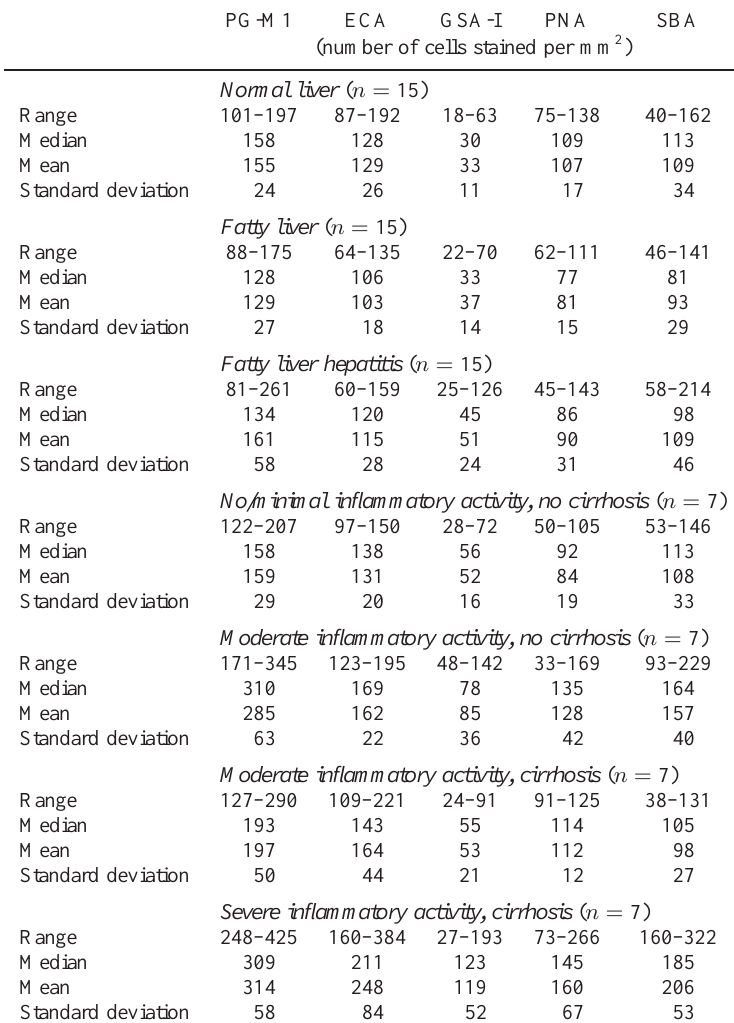
Table 2 Morphometric analysis of macrophages in the pericentral fields of normal